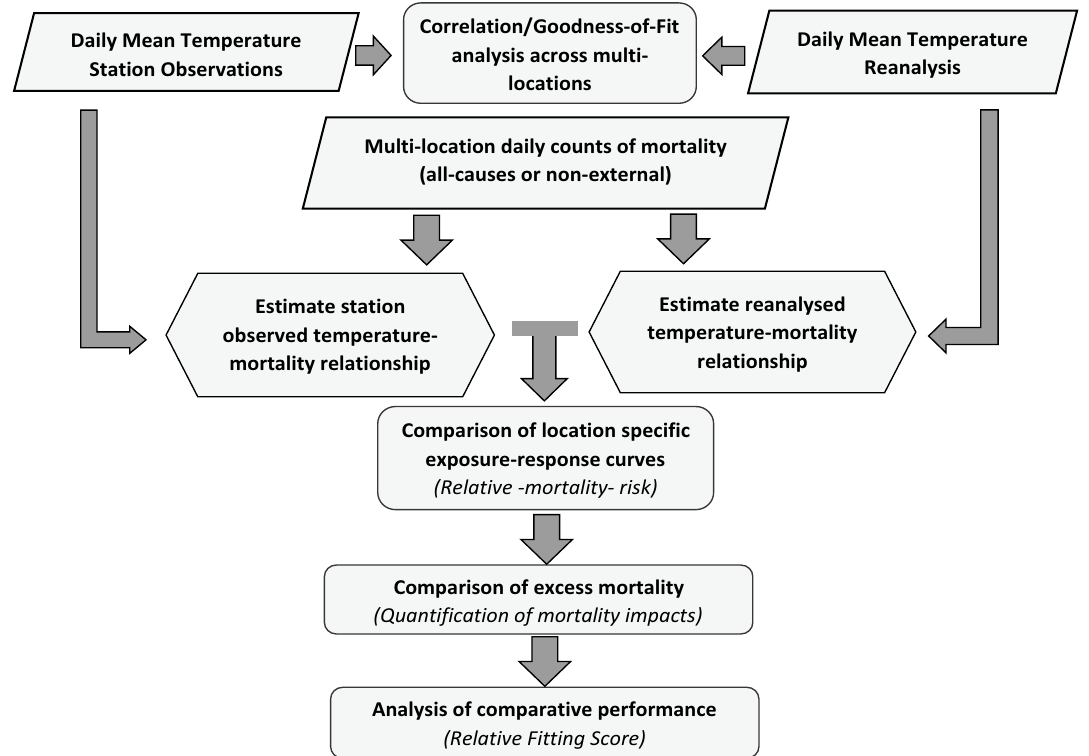
Figure 1. A schematic outline of the comparative analysis framework used in this study.